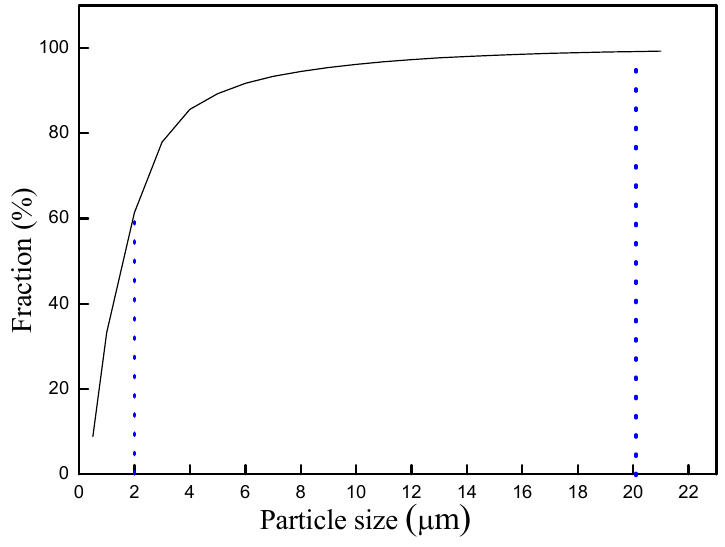
Figure 3. Cumulative particle-size fraction of the bauxite samples.